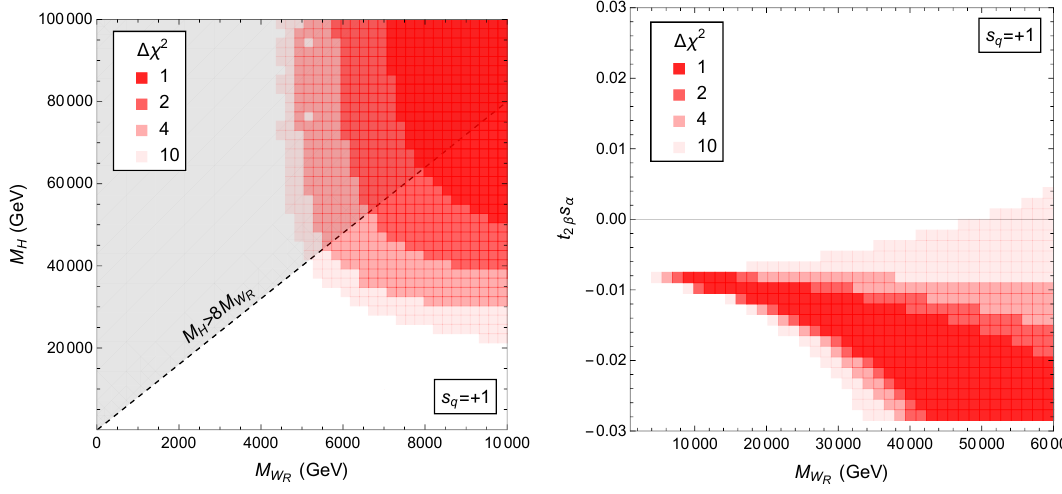
- M plane, after H R - t W R 2 β s α